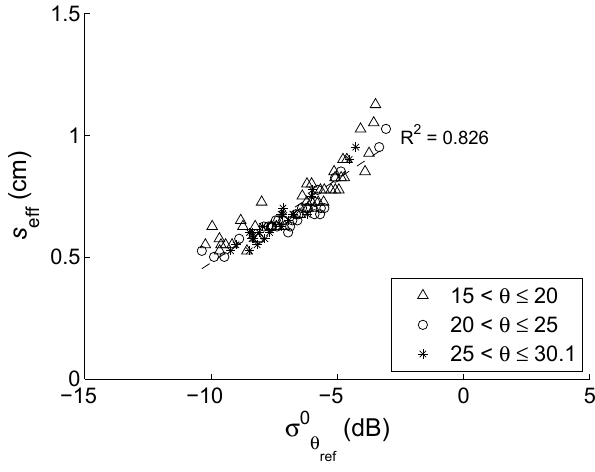
Fig. 9. Dependence of l eff on the normalised backscatter observations ( σ 0 ) for different intervals of incidence angle ( θ θ ref ).